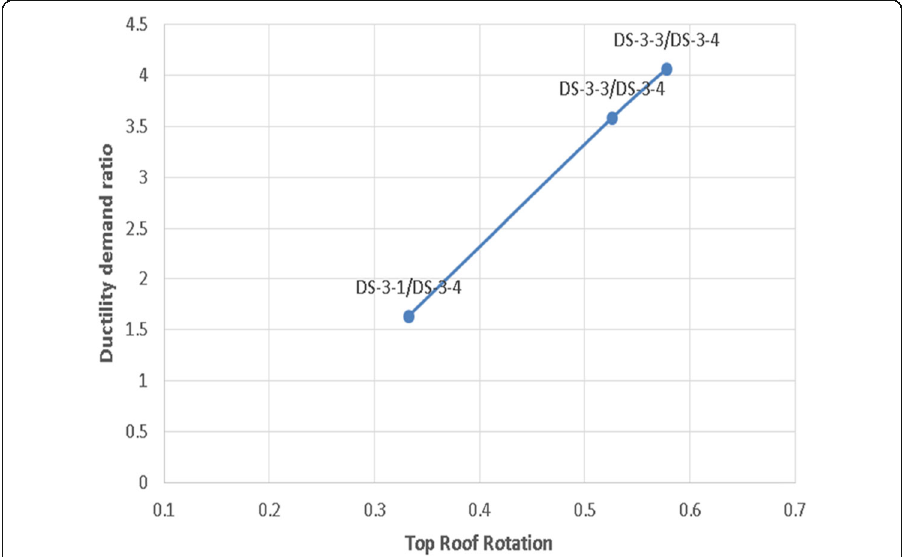
Fig. 28 Comparison of rotation — ductility demand the ratio for stiff elements located 16 m from center of mass for (DS-3-1, DS-3-2, and